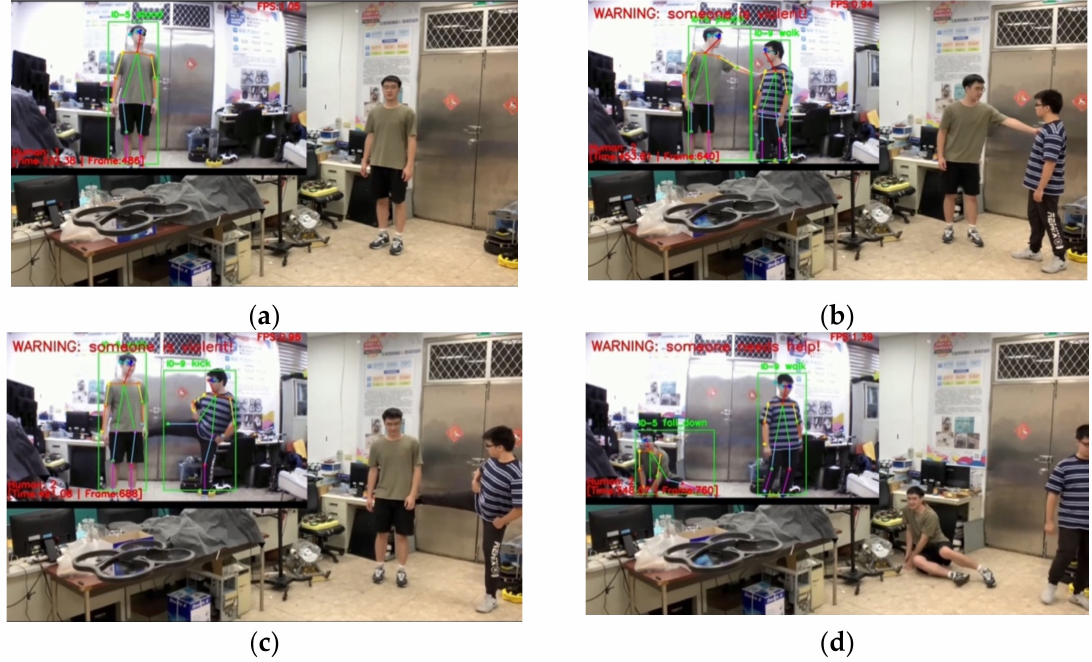
Figure 19. Indoor Behavior interpretation from the multiple postures recognized as: ( a ) Normal (stand posture); ( b ) Violent (one is stand and another is punch posture); ( c ) Violent (one is stand and another is kick posture); ( d ) Help needed (one is walk pose and another is fallen down